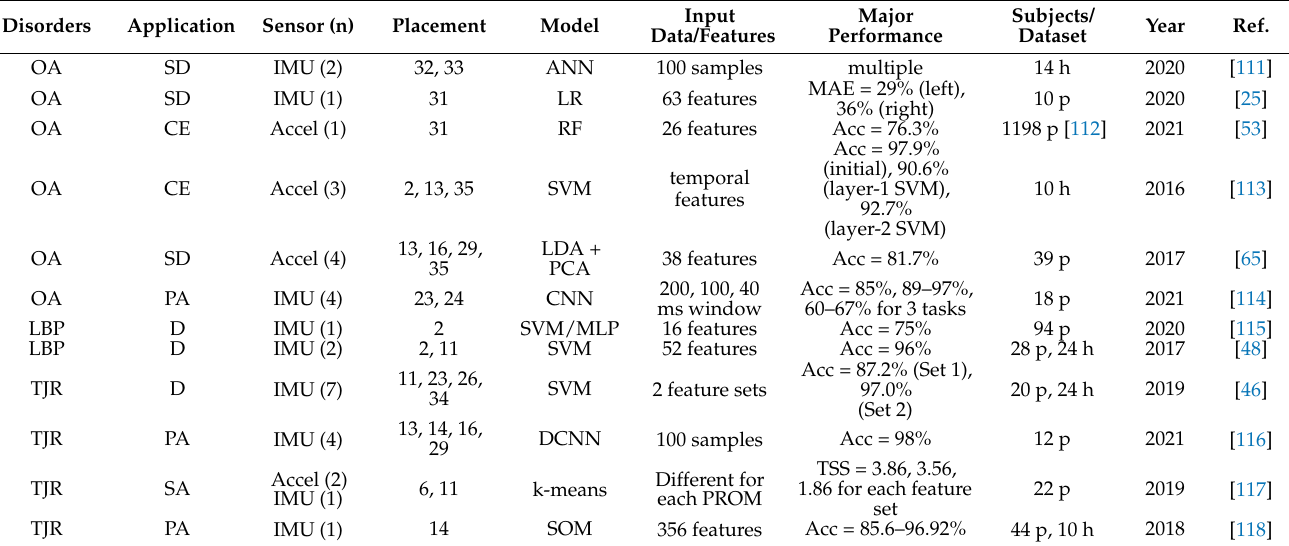
Table 3. Musculoskeletal